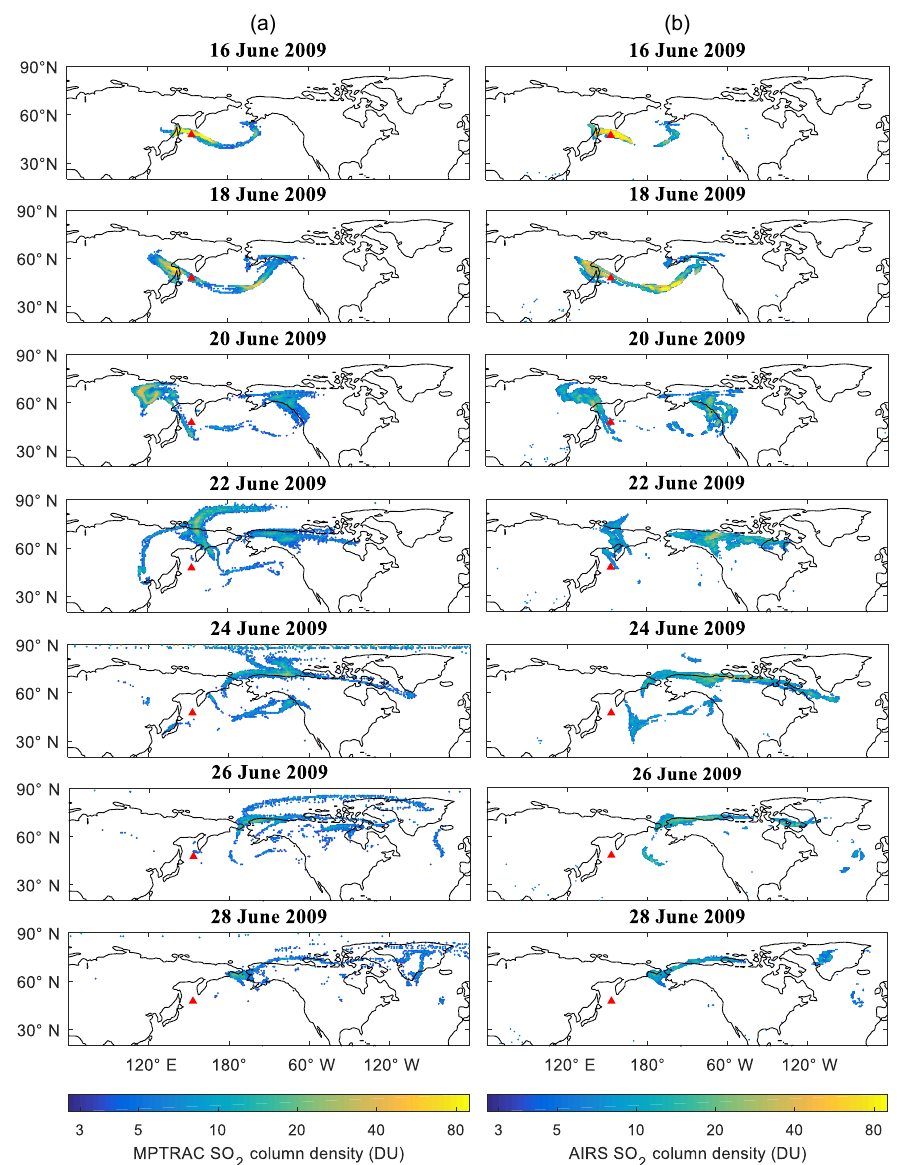
Figure 3. The evolution of SO 2 column densities from MPTRAC simulations (a) and AIRS observations (b) for 16–28 June 2009. The MPTRAC SO 2 column densities are shown for 00:00UTC on selected days and AIRS data are collected within ± 6h. Only values larger than 2DU are shown. The red triangle denotes the location of the Sarychev